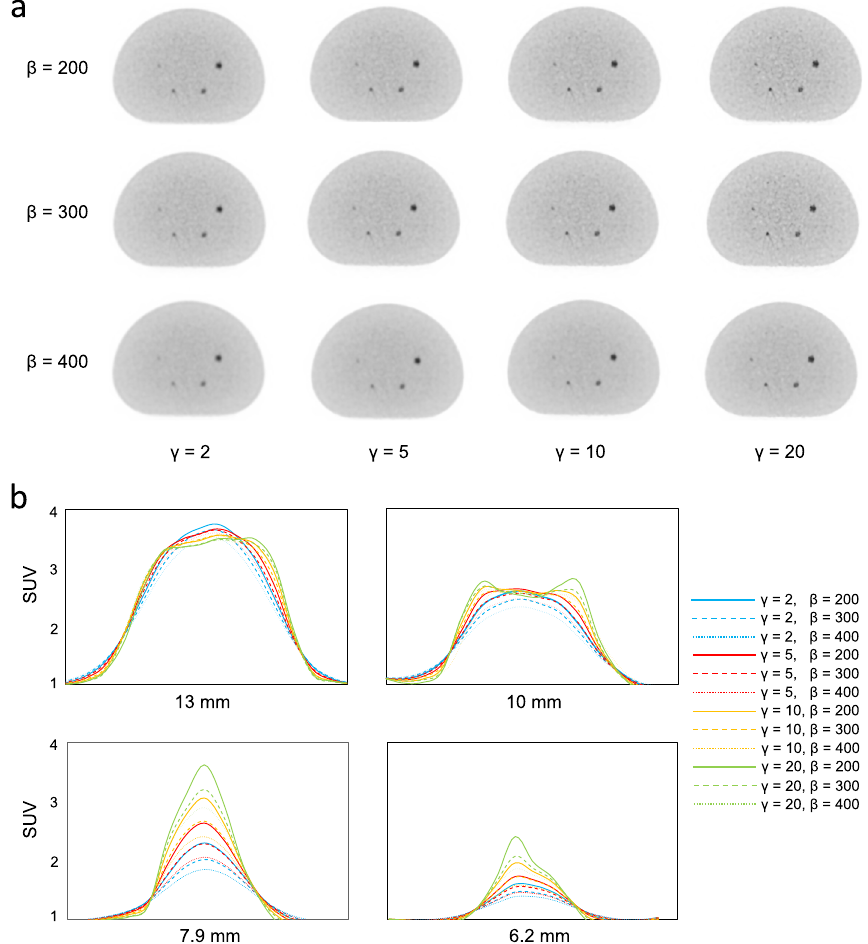
Fig. 6 Representative PET images reconstructed using various β values and γ factors ( a ) and profile curves of spheres ( b ). All images are shown as standard uptake values on a scale from 0 to